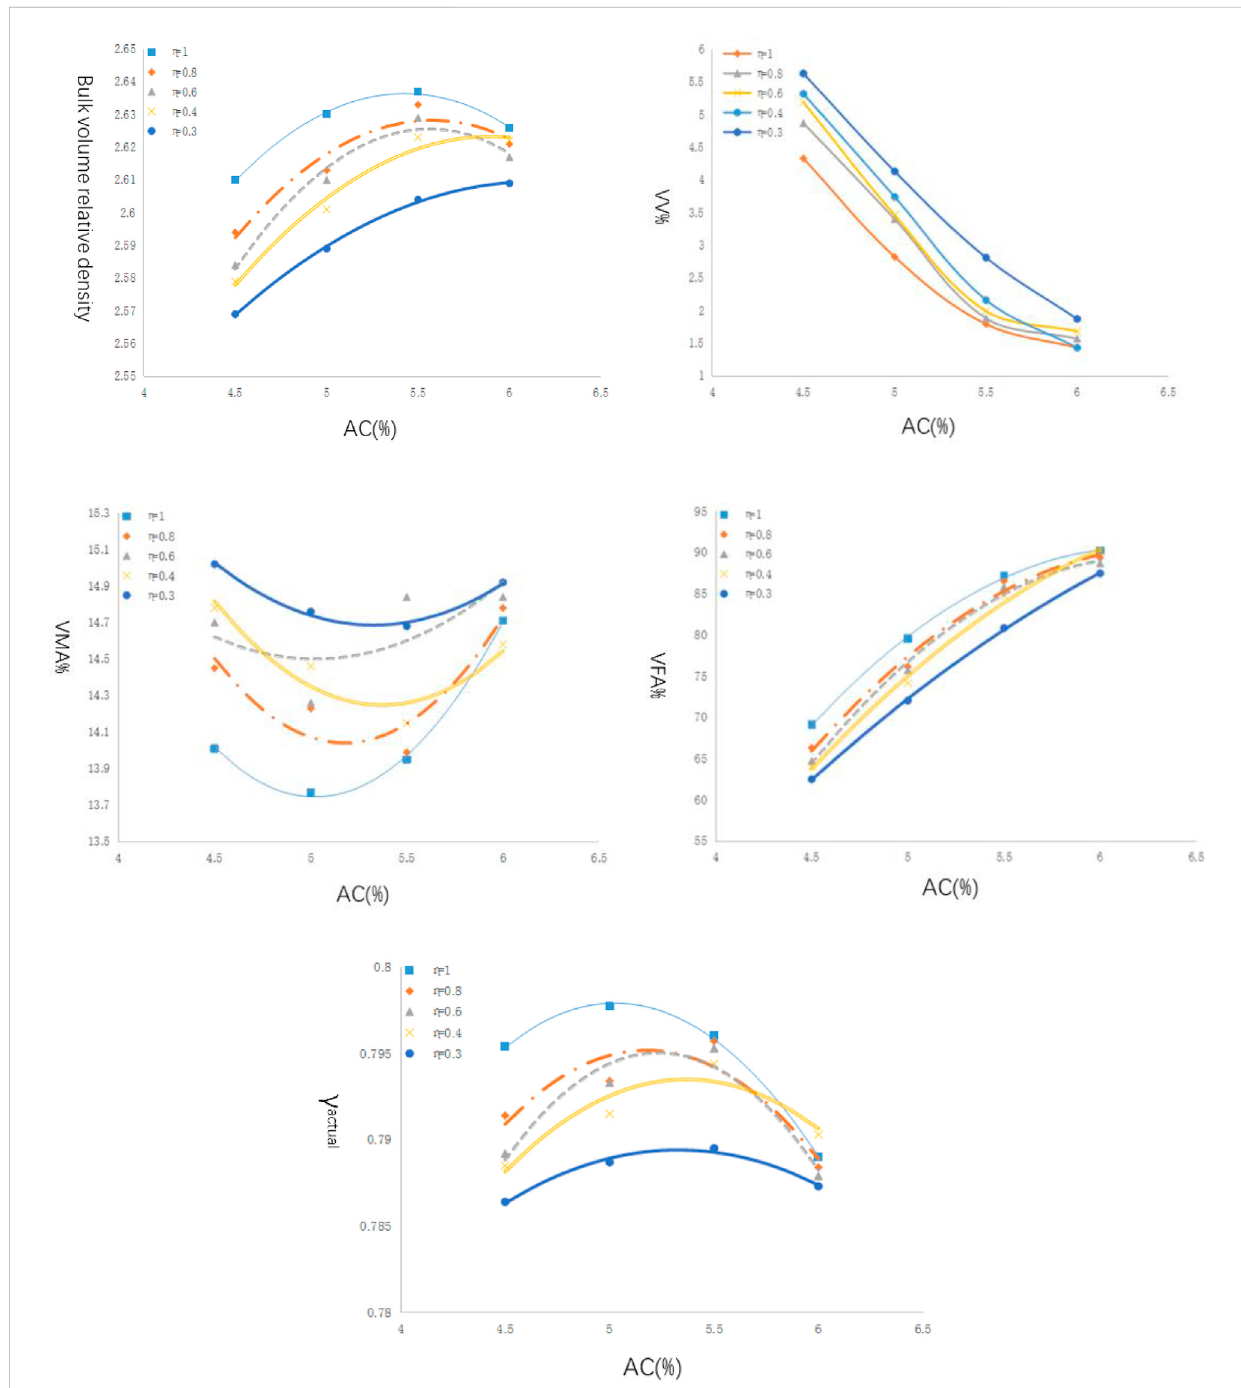
FIGURE 3 volumetric parameters with asphalt